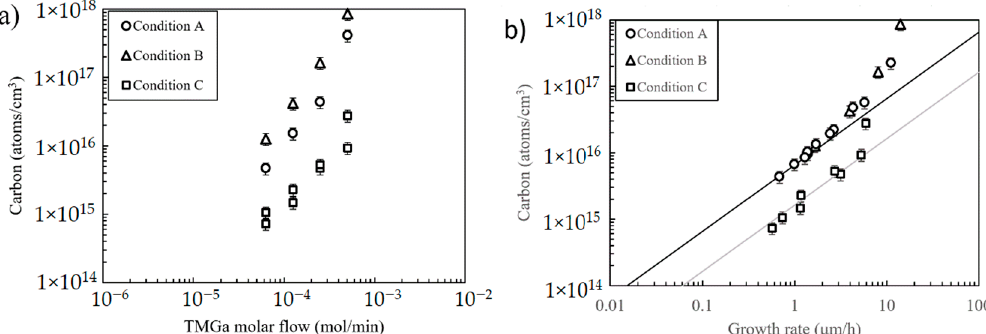
Figure 3. Carbon incorporation from SIMS analysis for all three OMVPE conditions plotted in ( a ) versus TMGa molar flow and in ( b ) versus growth